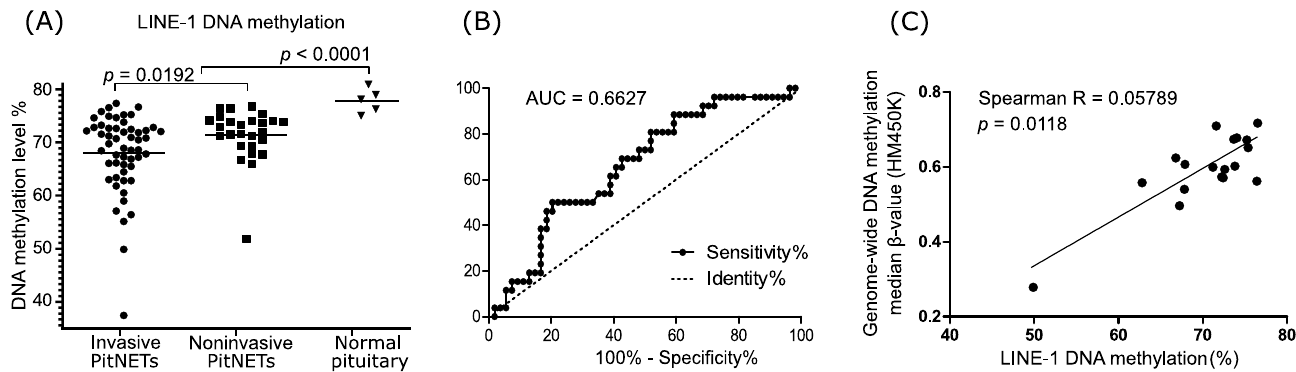
Figure 1. LINE-1 DNA methylation in nonfunctioning gonadotroph PitNETs. ( A ) Comparison of invasive ( n = 54) and noninvasive ( n = 26) tumors. Each dot represents average LINE-1 methylation level in the sample. Horizontal lines indicate mean values; ( B ) ROC (receiver operating characteristic) curve analysis for LINE-1 DNA methylation as classifier of invasive growth status; ( C ) Correlation between LINE-1 methylation and genome-wide methylation levels estimated as median β -value from HM450K arrays. Each dot represents PitNET sample ( n =